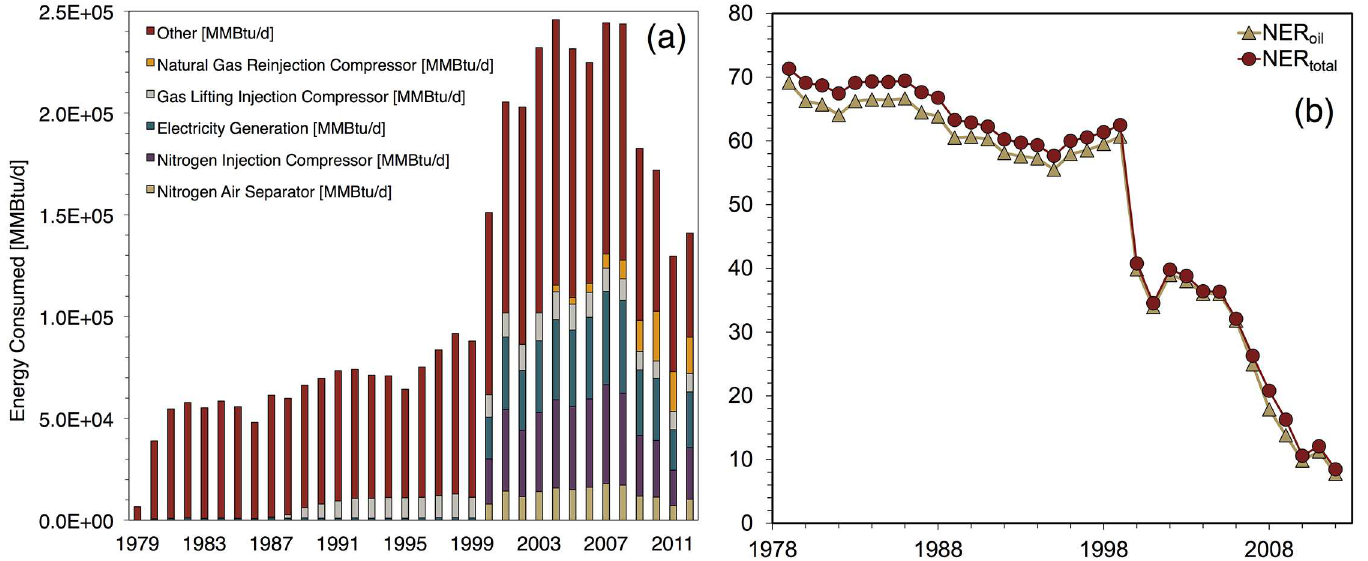
Fig 7. Cantarell base case results showing (a) total energy inputs for major processes(b) NER